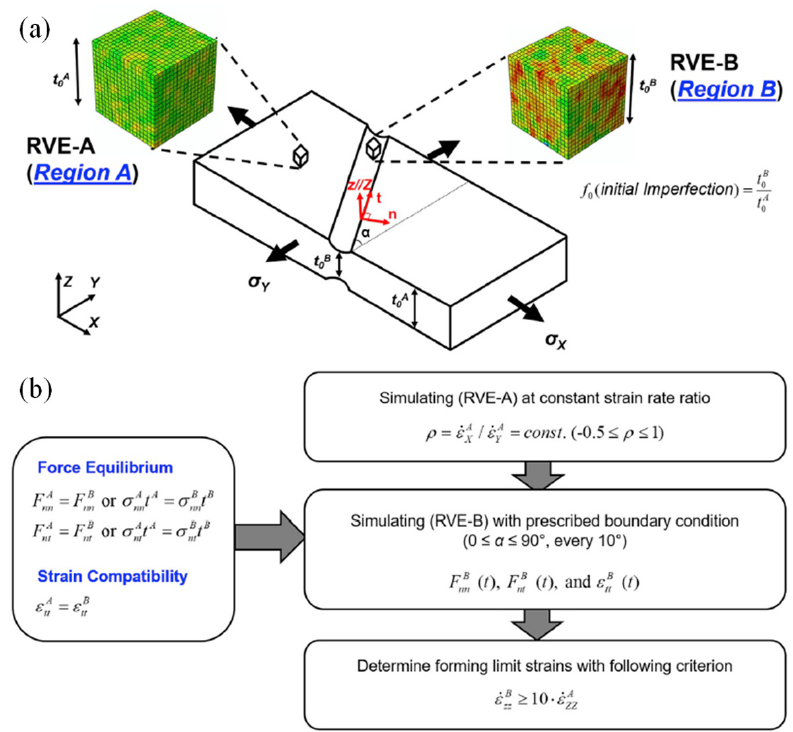
Figure 35. A schematic description of the novel multiscale approach proposed by Bong et al. [437] to predict the FLDs of AZ31 and ZE10 Mg sheets. Reprinted from Ref. [437] with permission. Copyright 2020, Elsevier. ( a ) schematic of the proposed hybrid